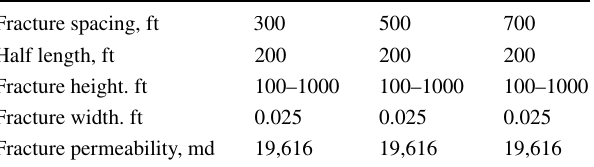
Table 3 Fracture